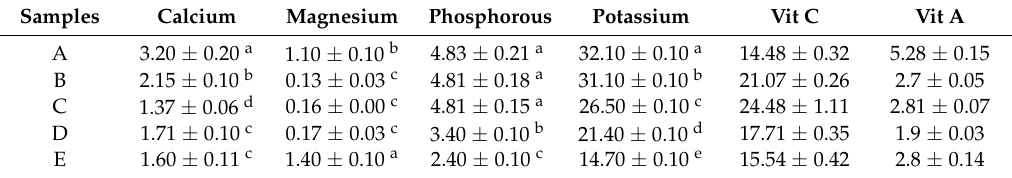
Table 3. Mineral elements and vitamin composition of carrot-cucumber juice (mg/100